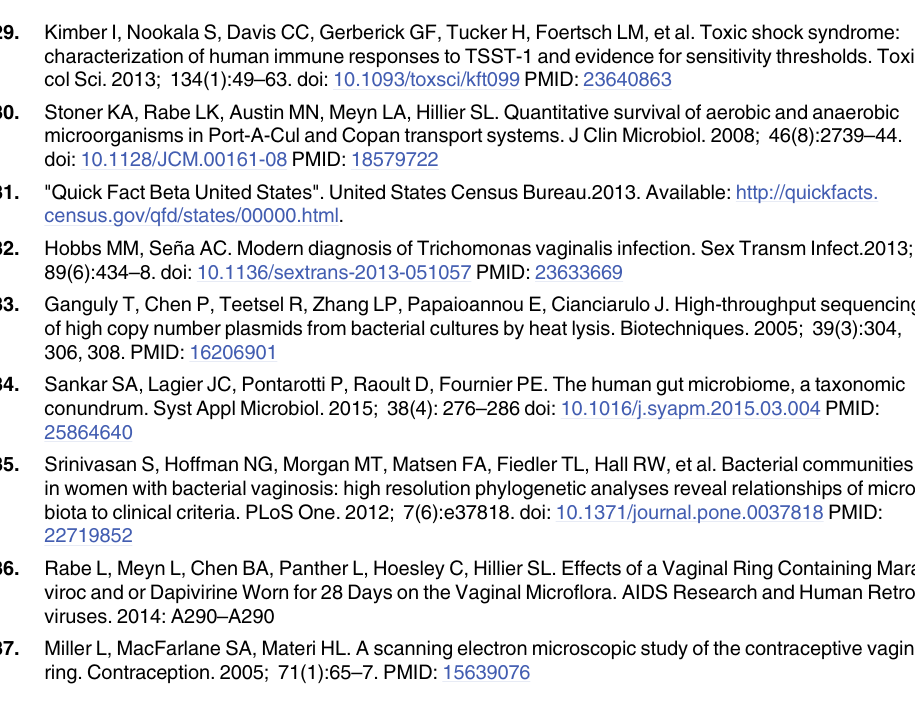
PLOS ONE | DOI:10.1371/journal.pone.0134460 August 12,